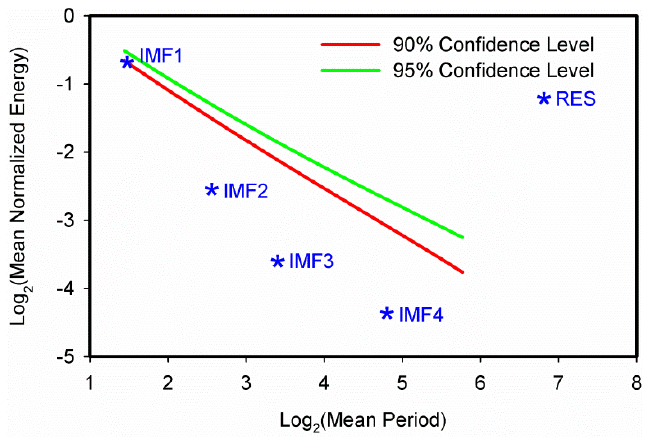
Figure 5. Significant test results for the IMFs of average annual precipitation time series during 1960–2012 in Xinjiang.